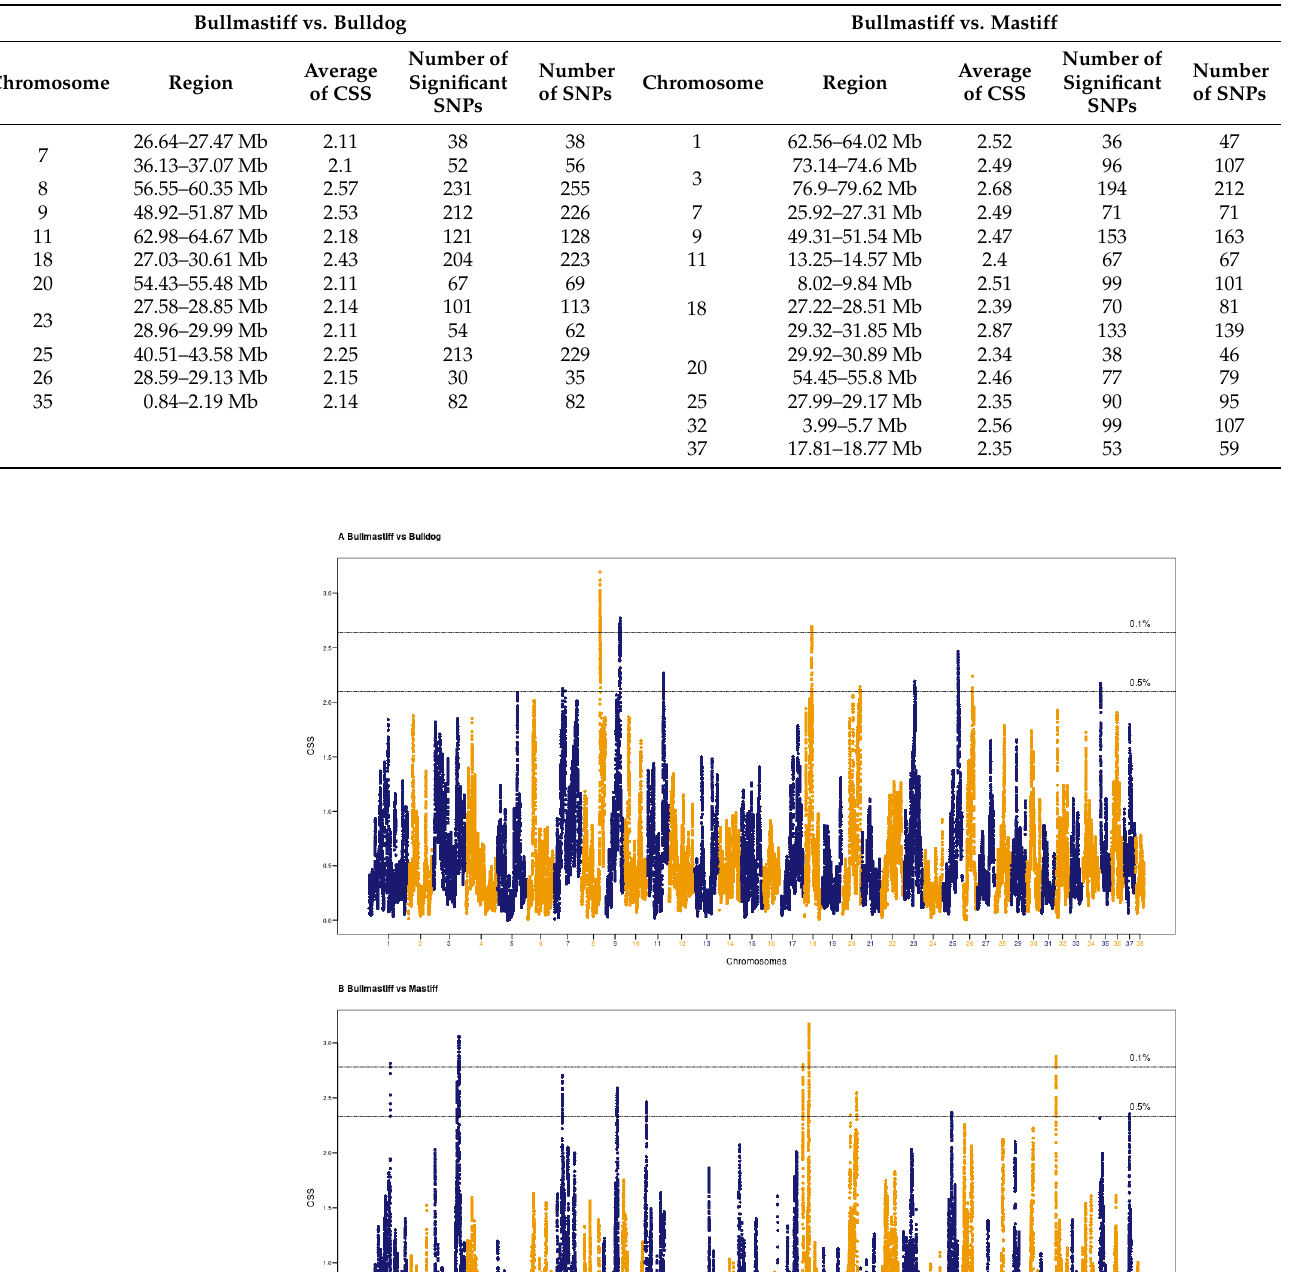
Table 2. Summary of significant regions identified in Bullmastiff dogs using Bulldog or Mastiff as reference populations.